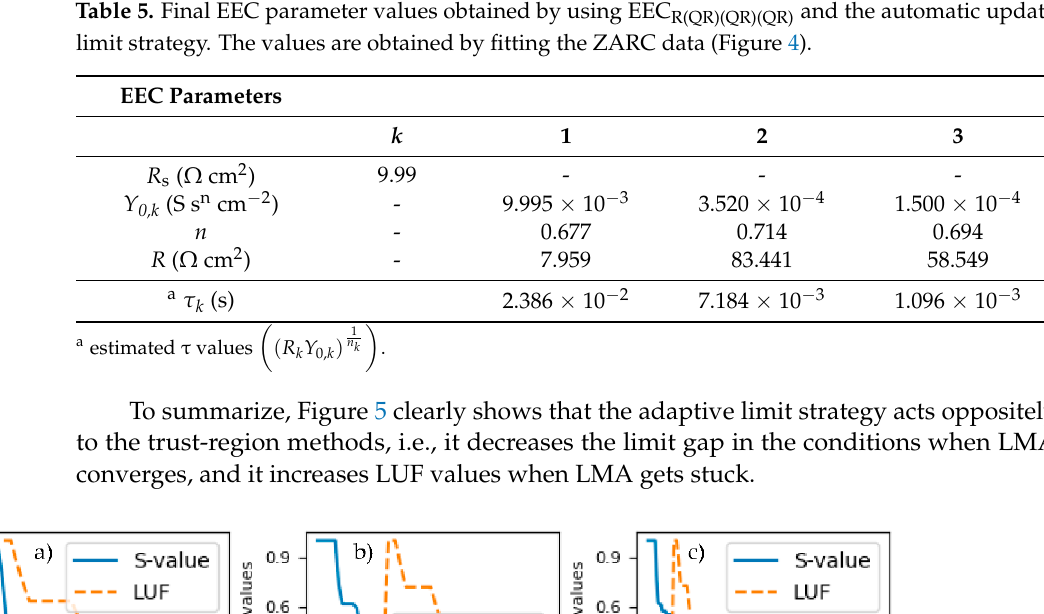
Figure 5. S -value and limits update factor (LUF) data obtained while using the automatic update limit strategy in ( a ) Figure 2, ( b ) Figure 3, and ( c ) Figure 4. EEC R(QR)(QR)(QR) (Figure 1) was used in the fitting